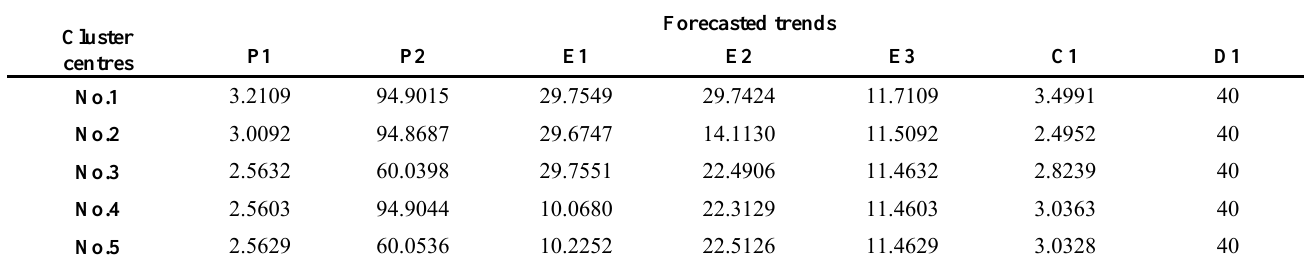
Table 6: The final main scenarios and their ranking score Main Final